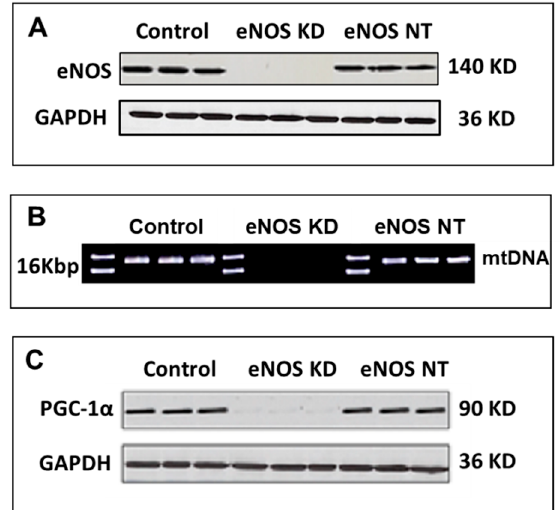
Figure 1. Confirmation of endothelial nitric oxide synthase (eNOS) knockdown (KD) in human mes- enchymal stem cells (hMSC): ( A ) Western blot analysis of eNOS protein expression, ( B ) mitochondria DNA (mtDNA) analysis by agarose gel electrophoresis, and ( C ) Western blot analysis of PGC-1 α protein expression. Abbreviations: KD, knockdown; NT, nontargeting control.